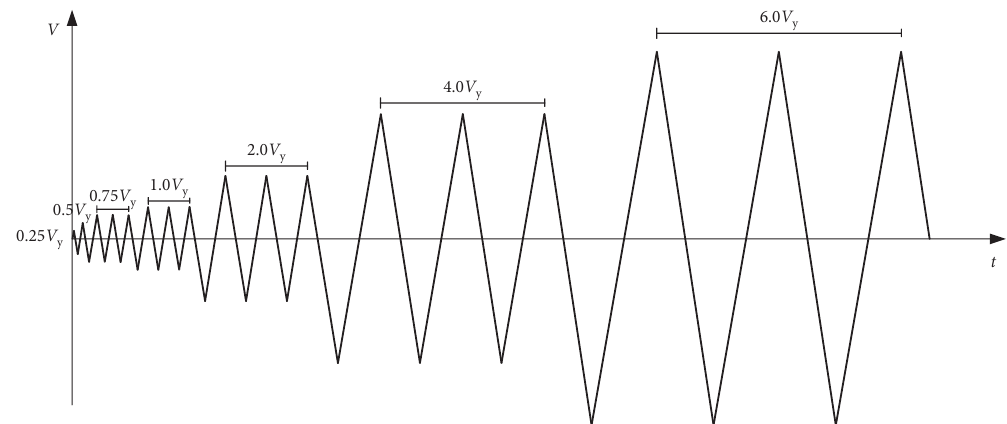
Figure 6: Loading protocol recommended in EN 12512 (2001).